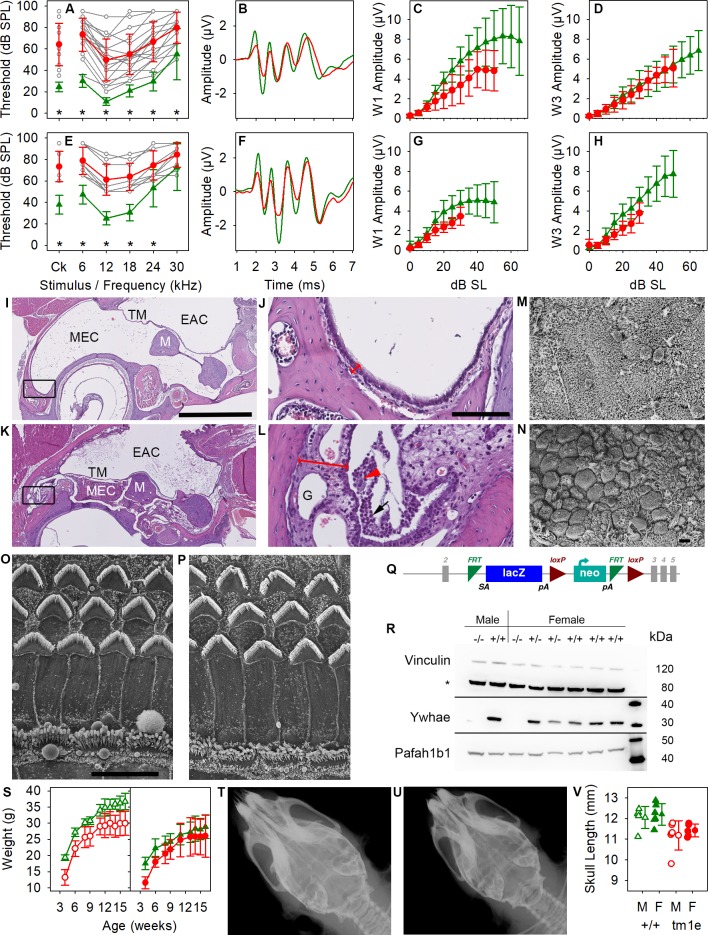
Pathology of the Ywhae mutant.ABR thresholds were significantly raised at 8 weeks old in mutants (A,E) (Mann–Whitney U test, p < 0.001) but were highly variable between individuals (grey lines), while click-evoked ABR waveforms were close to normal (B,F show group mean waveforms at 20 dB above threshold), and reduced but nonsignificant amplitude growth with increasing stimulus level in mutants (C,D,G,H) (Mann-Whitney-Wilcoxon test with Holm correction for multiple testing). Ywhae homozygotes (red) and wild-type littermates (green) with individual mutant thresholds (grey) on a 50% C57BL/6N, 50% 129S5 (A-D) (n = 18 homozygotes, 12 wild types for thresholds; n = 10 homozygotes, 11 wild types for amplitude functions) or a 12.5% C57BL/6N, 87.5% 129S5 genetic background (E-H) (n = 9 homozygotes, 13 wild types for thresholds; n = 6 homozygotes, 13 wild types for amplitude functions). Heterozygotes have normal ABR thresholds. (I-L) Coronal sections of the middle ear in wild type (I,J) and homozygous Ywhae mutants (K,L). The tympanic membrane is retracted in the mutant, and the middle ear contains inflammatory debris. The mucosa is thicker in the mutant (double-headed red arrow), containing granulation tissue (‘G’), infiltrated immune cells (black arrow in L), and foamy macrophages (red arrowhead). Black rectangles in I and K indicate the areas enlarged in J and L. Scale bar for I and K is 1 mm; in J and L it is 100 μm. n = 2 homozygotes, 2 heterozygotes, 4 wild types. M,N. Scanning electron micrographs of the middle ear epithelium near the opening of the Eustachian tube in wild-type (M) and homozygous Ywhae mutant (N), showing widespread goblet cells and fewer ciliated epithelial cells in the mutant compared with the wild type, which is rich in ciliated cells. Scale bar is 10 μm. n = 5 homozygotes, 5 heterozygotes, 3 wild types. O,P. Scanning electron micrographs of the organ of Corti in a heterozygote (O) and homozygous mutant (P) showing normal appearance. OHCs are shown at the top, each with a V-shaped stereocilia bundle, and IHCs at the bottom. Images taken from 60% of the distance along the cochlear duct from the base. n = 7 homozygotes, 5 heterozygotes, 2 wild types. Scale bar is 10 μm. Q. Design of the Ywhaetm1e(EUCOMM)Wtsi mutation with exons in grey, FRT sites in green, loxP sites in red, and lacZ and neo components of the inserted construct labelled. R. Western blot of Ywhae and Pafah1b1 (Lis1) protein in brain showing no detected Ywhae in homozygous mutants (−/−), while expression of Pafah1b1 (encoded by a nearby gene) was unaffected. Vinculin was used as a loading control. n = 2 homozygotes, 2 heterozygotes, 4 wild types. S. Body weight growth with age in males (left) and females (right), showing significantly reduced weights in homozygotes (red) compared with wild types (green) (males, n = 7 homozygotes, 6 wild types; females, n = 7 homozygotes, 7 wild types; mixed model framework test as described by Karp and colleagues [42] at 4 weeks, 16 weeks, and area under the curve, p = 6.9 × 10−3, 0.013, and 6.9 × 10−3 respectively). T-V. X-rays of wild type (T) and homozygotes (U) showing shorter skull length (V) in the mutants (p = 3.9 × 10−5; n = 6 male and 5 female homozygotes and 5 male and 6 female wild types; mixed model framework test, males and females p = 3.9 × 10−5). All plots are means ± standard deviation. Plotted data points are given in S9 Data. ABR, auditory brainstem response; Ck, click; EAC, external auditory canal; FRT, flippase recombinase target; IHC, inner hair cell; lacZ, gene encoding β-galactosidase; loxP, locus of crossover in P1 bacteriophage; M, malleus; MEC, middle ear cavity; OHC, outer hair cell; SL, sensation level; SPL, sound pressure level; TM, tympanic membrane.